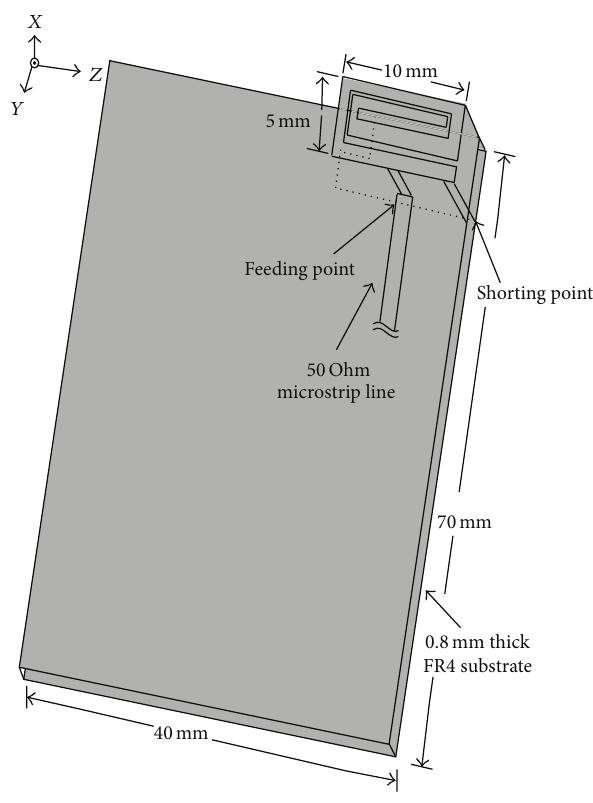
Figure 1: Proposed dual-band meander inverted-e-shaped